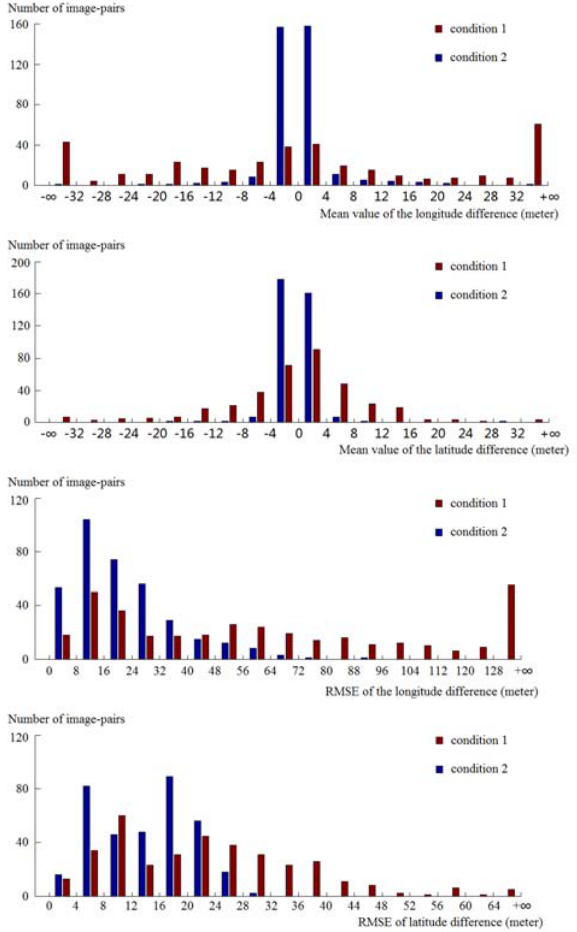
Figure 8. The histograms of the mean value and RMSE of the ground position difference of the corresponding points in all the image-pairs. The relative precision of the whole test area in condition 2 is obviously better than that in condition 1, whether judged by the mean value of by the RMSE.